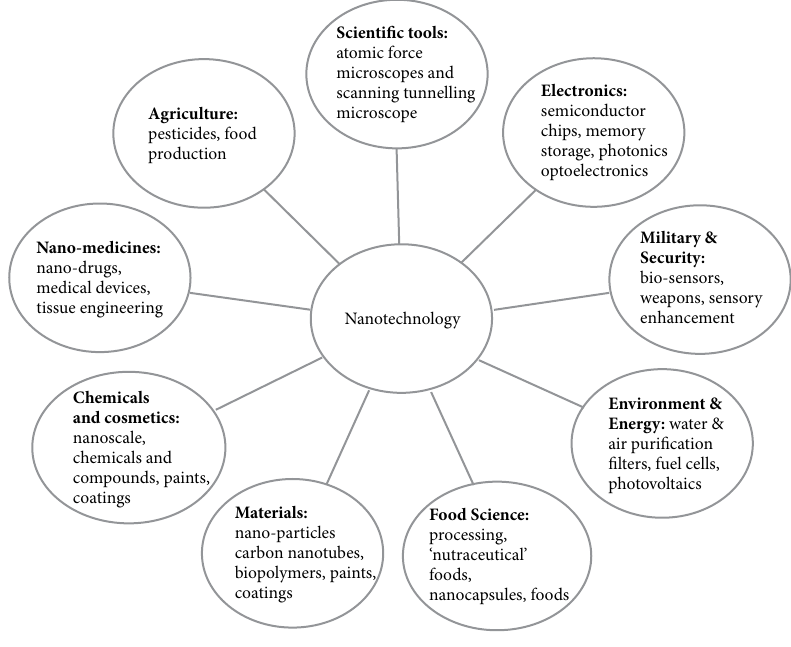
Fig. 1. Nanotechnology applications (Hodge & Bowman